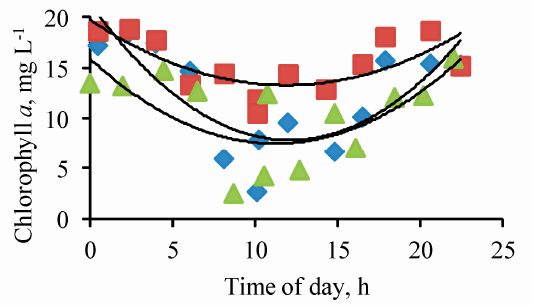
Figure 3. Diurnal changes of the chlorophyll a content in three stations (squares—1st station, rhombuses—2nd station, triangles—3rd station) of Lake Moynaki during 15–16 September 2021. At site 1, minimum concentration was observed at about 10:00, 2.65 µ g L − 1 , at site 2—at 10 a.m., 10.50 µ g L − 1 , and at site 3—at 8:40 a.m., 2.49 µ g L − 1 . The maximum